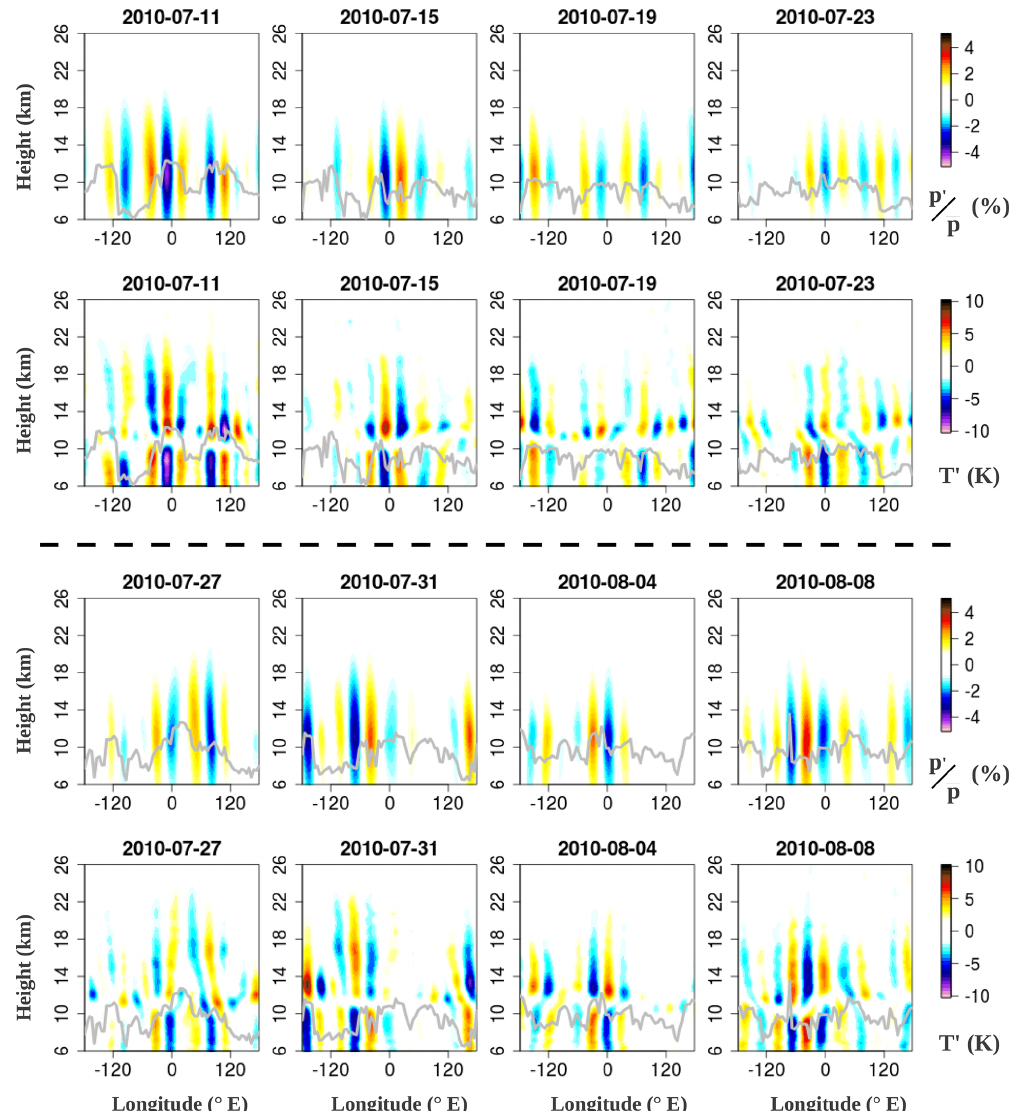
Figure 9. Longitude–height snapshots of (fist and third rows) pressure and (second and fourth rows) temperature anomalies of the RWP from Fig. 8 at 55 ◦ N. The grey line denotes the gridded lapse-rate tropopause